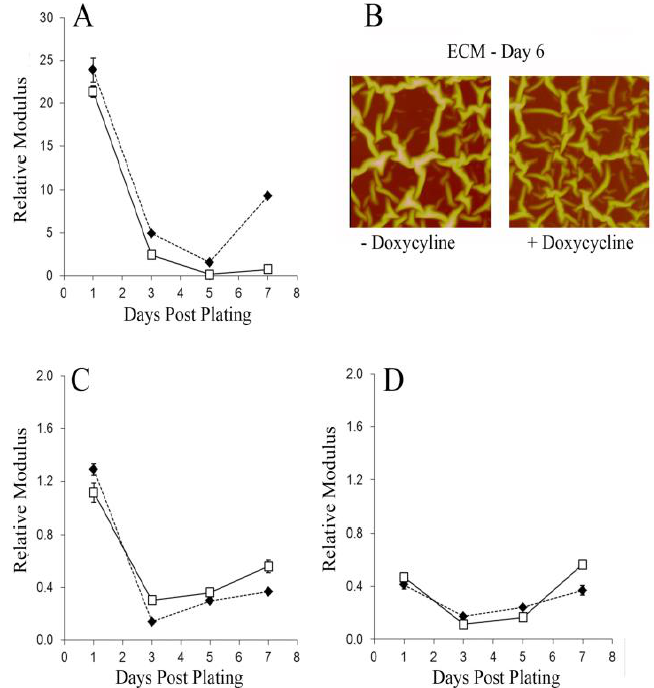
Figure 3. ( A ) Relative moduli of C9 cells plated on sulfonated PSS 28 coated Si wafers with DOXY − / rhBMP2 + medium (filled circles) and DOXY + / rhBMP2 − (clear circles). ( B ) Topographical atomic force microscopy images of the extracellular matrix (ECM) fibers produced by the cells expressing (left) and not expressing BMP2 (right) after 6 days of incubation. Relative modulus of the ECM fibers ( C ) and interfiber spaces ( D ) are also shown.